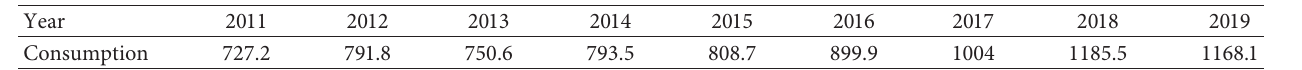
Table 3: Per capita consumption of domestic electricity in Beijing from 2011 to